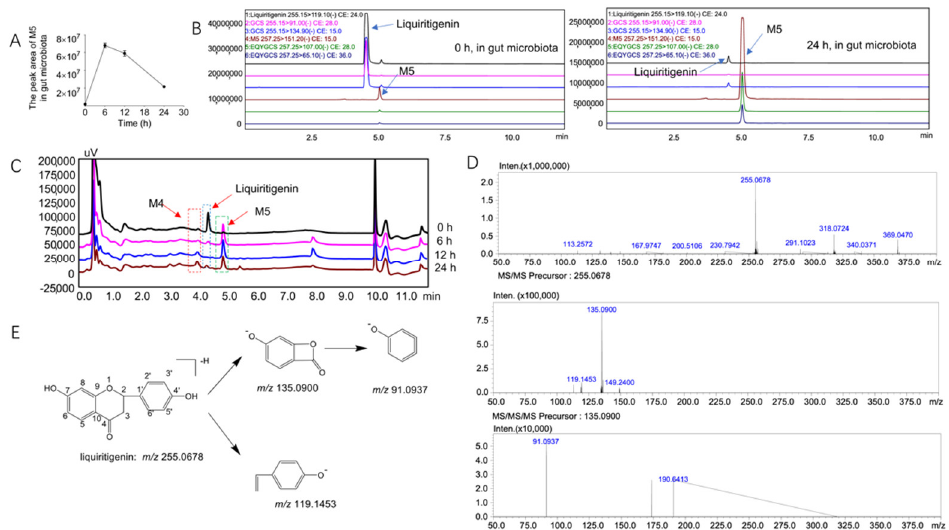
Figure 3. The metabolites of M5 in the gut microbiota and the mass spectrometric cleavage pathway of liquiritigenin. ( A ): Time-dependent curve of M5 after incubation with rat intestinal flora for 0 h, 6 h, 12 h and 24 h; ( B ): EICs of parent drug liquiritigenin and metabolite M5 after 0 h and 24 h of incubation in the rat intestinal flora system; ( C ): liquid EICs of liquiritigenin and metabolites M4 and M5 after 0 h, 6 h, 12 h, and 24 h of incubation; ( D ): MSn data of liquiritigenin; ( E ): possible cleavage of liquiritigenin.